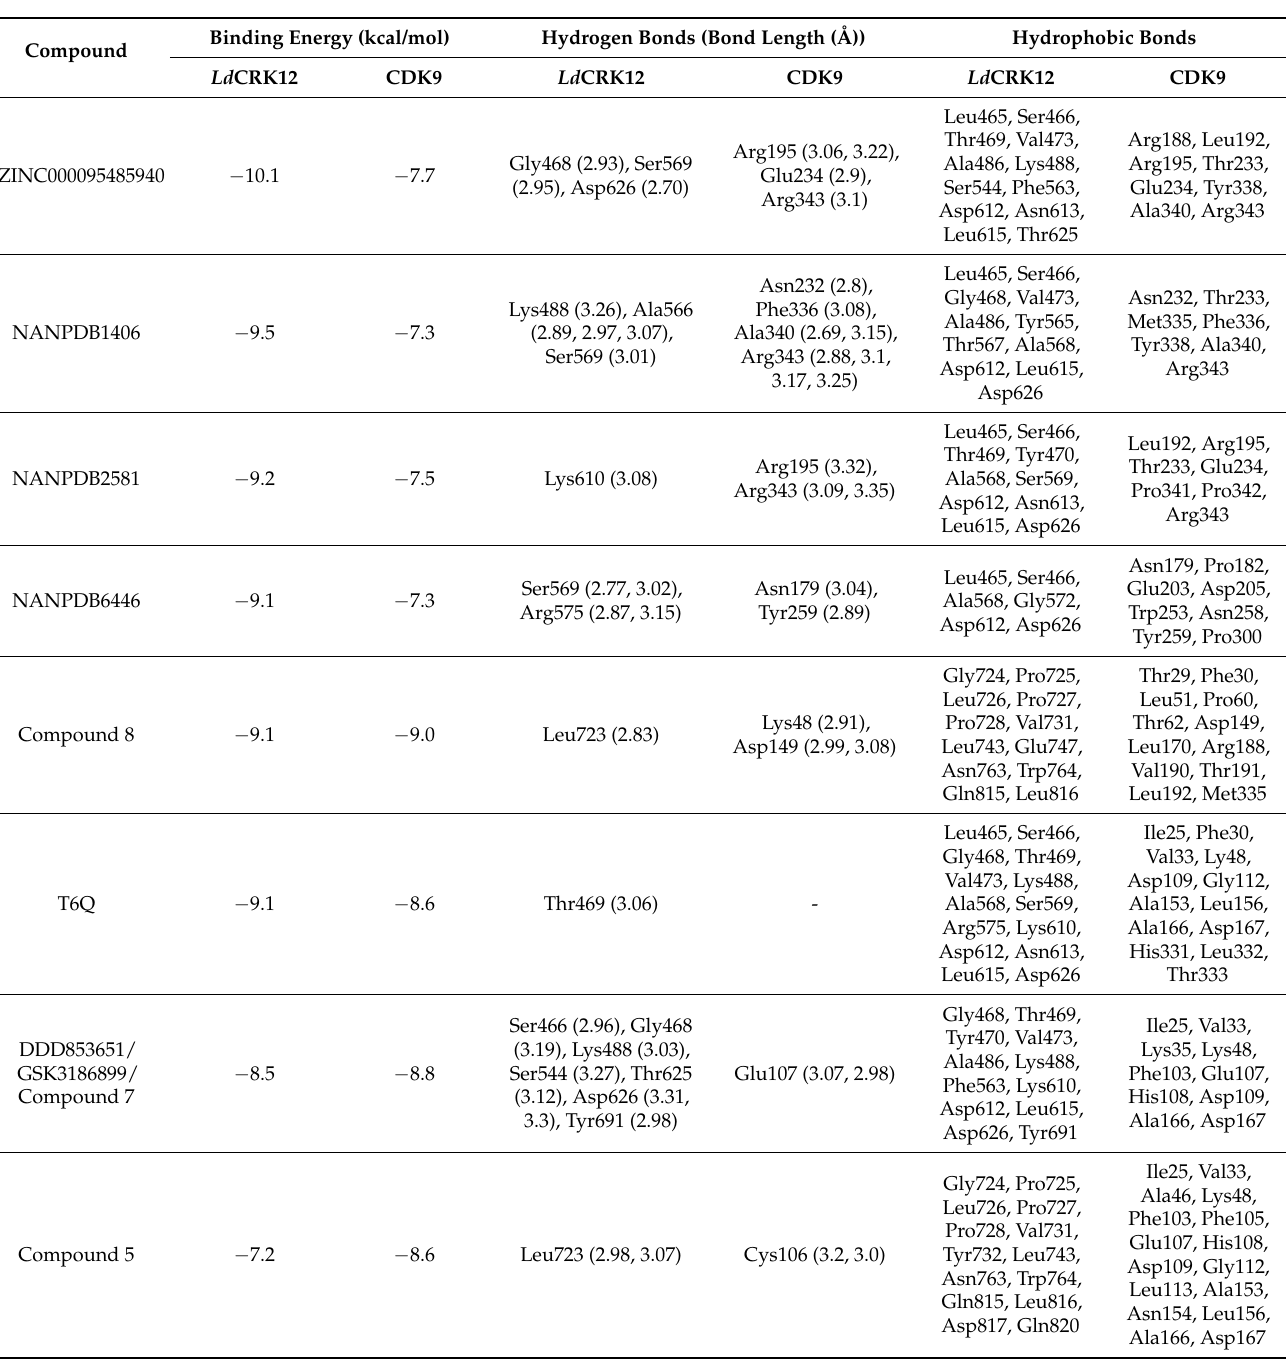
Table 8. The binding energies and intermolecular bonds between Ld CRK12 and selected compounds.